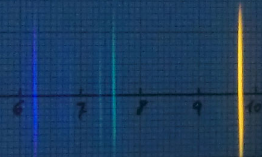
FIG. 2. English version of the interview questions for teachers used to investigate essentially the same topics as the questionnaire for students. In this case, the questions Q1T-absorption spectra and Q2T-emission spectra are more open ended than the first two questions of the questionnaire for students. Q1T prediction of absorption spectra, Q2T prediction on emission spectra, and Q3T-spectra lines intensity, interpretation of spectral lines ’